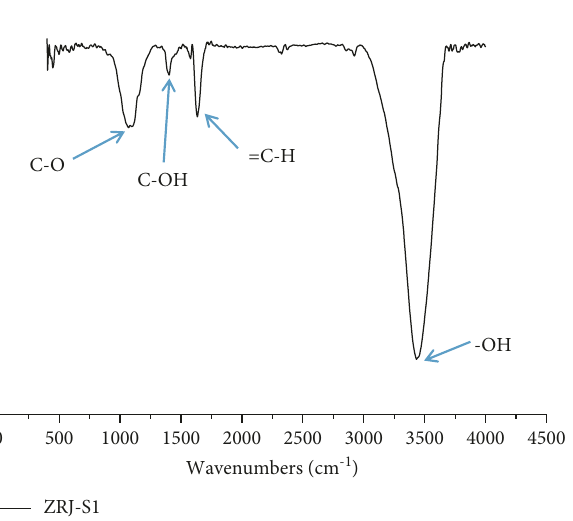
Figure 1: FTIR analysis of ZRJ-S1